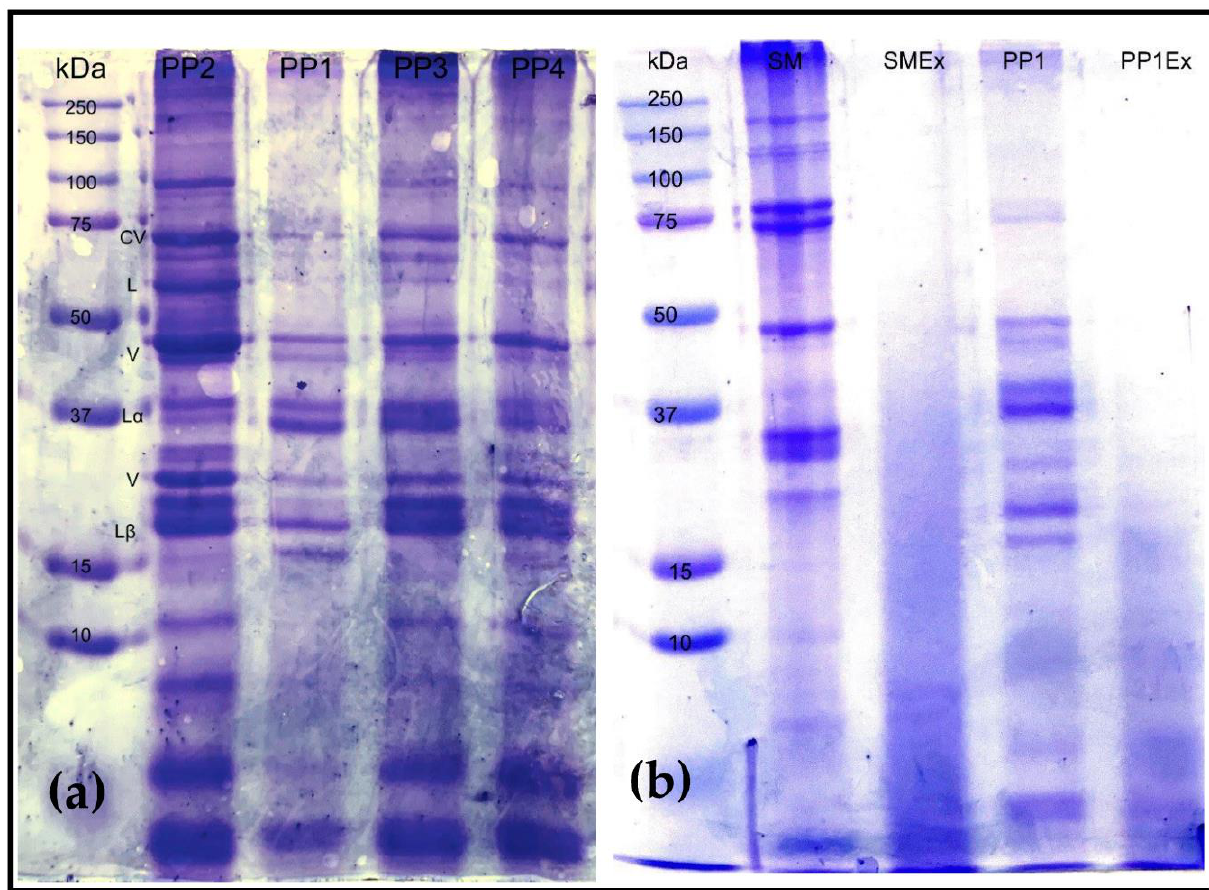
Figure 8. Non-reducing SDS-PAGE gel for raw pea proteins ( a ) and select raw and extruded proteins ( b ). Columns in ( a ) are the standard marker, PP2, PP1, PP3 and PP4. Note that PP2 comes before PP1. Columns in ( b ) are the standard marker, raw soy mix (SM), soy mix extruded (SMEx), PP1 and PP1 extruded (PP1Ex). CV, Convicilin; L, Legumin; V, Vicilin; Lα, acid subunit of legumin; Lβ, basic unit of legumin.